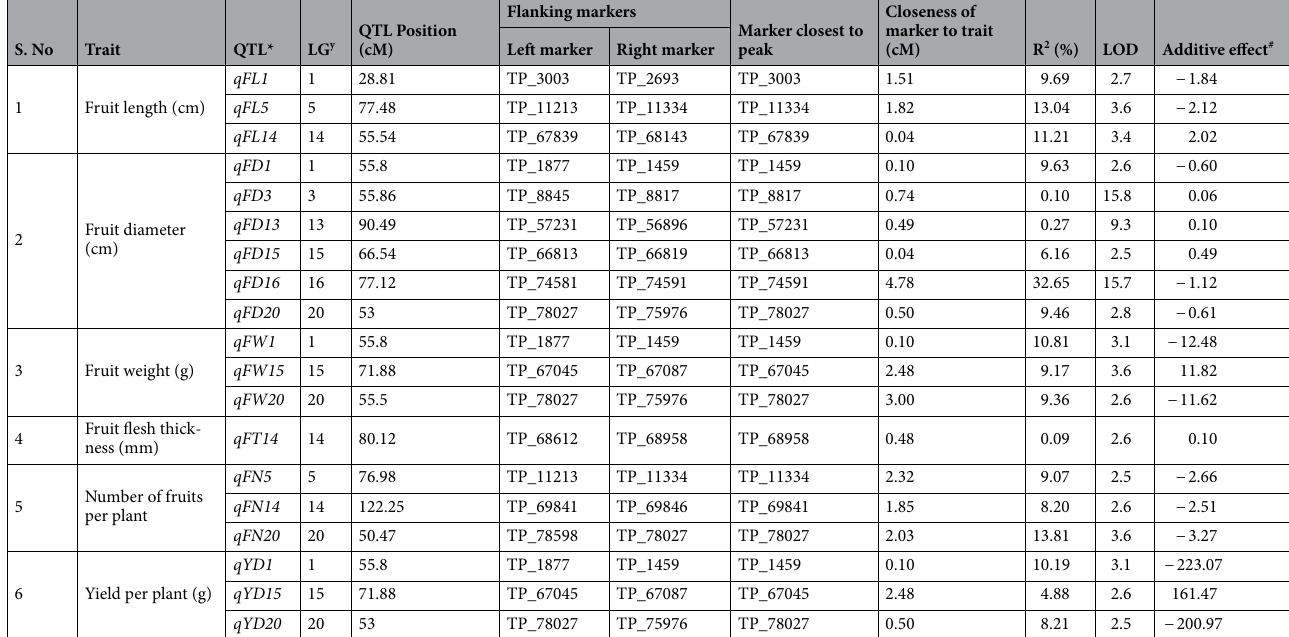
Table 2. QTL analysis of fruit traits in bitter gourd in F 2:3 family lines. *QTL named as qxxxy , with “ xxx ” being the trait abbreviation, ‘ y ’ the number of the linkage group. # Additive effect was positive when the “DBGy-201” allele increased the trait score and was negative when the “Pusa Do Mausami” allele increased trait score. The 95% confidence interval of the QTL locations was determined with 2-LOD support interval which was defined by left and right